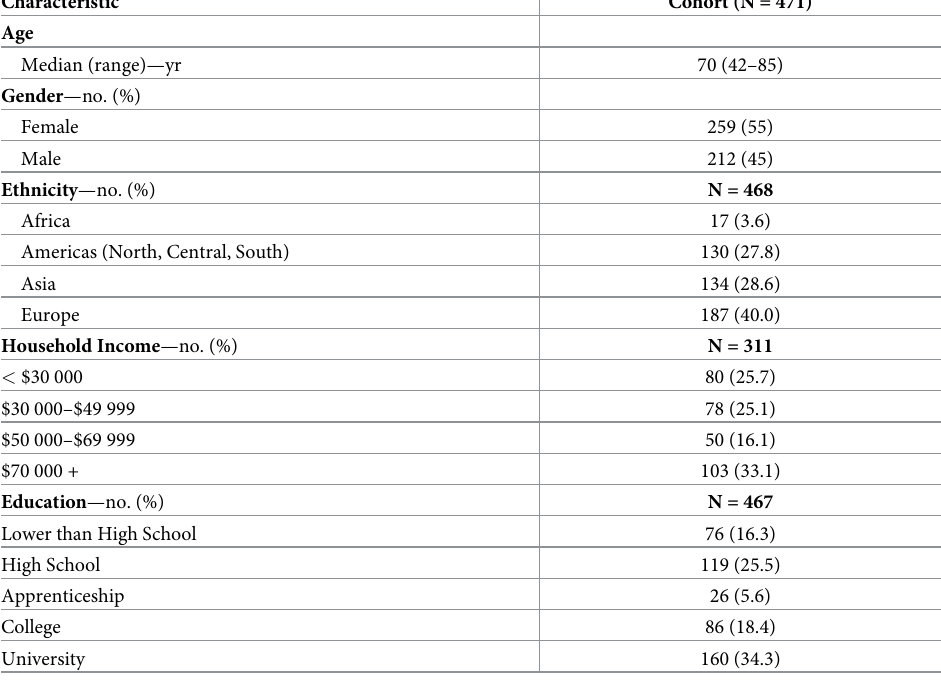
Table 1. Patient